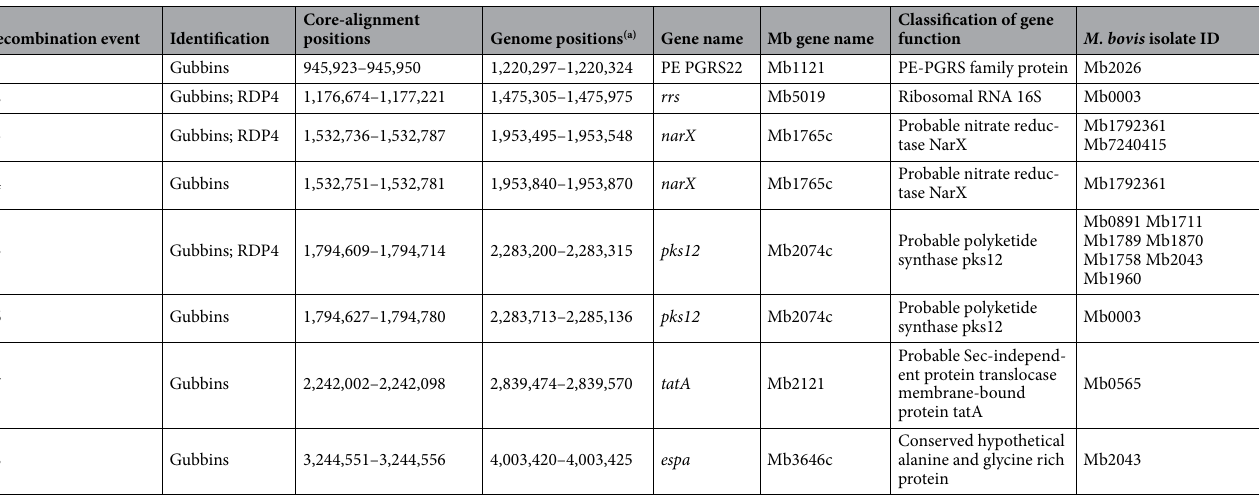
Table 4. Detailed information concerning the recombination events identified by Gubbins and RDP4 in the entire dataset. Genome positions according with M. bovis AF2122/97.